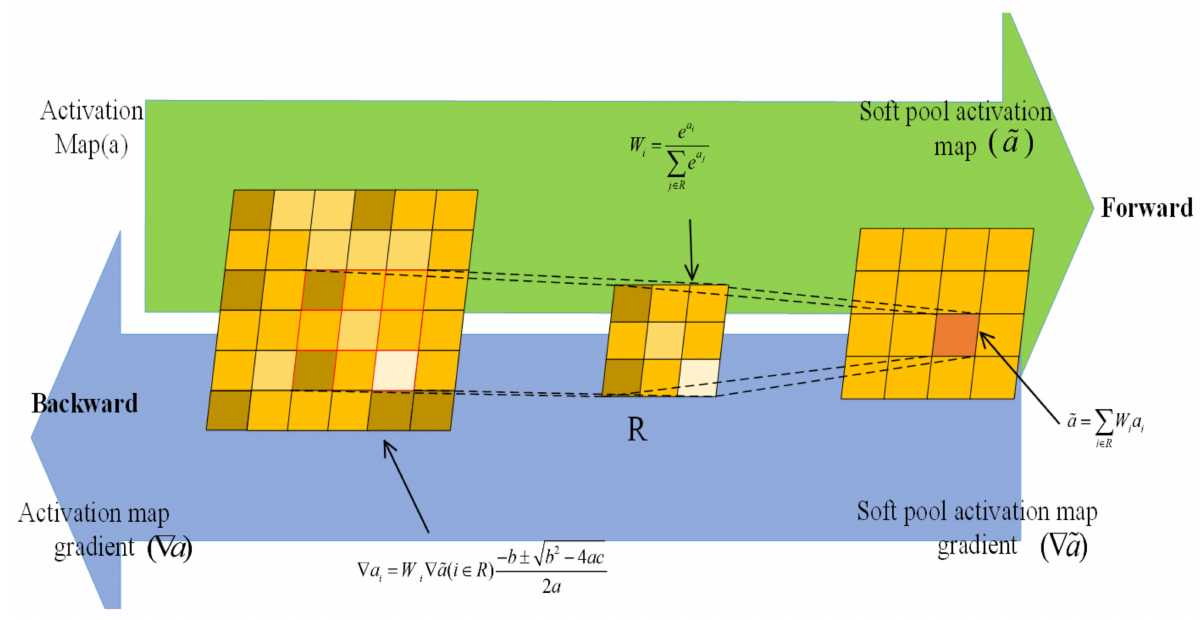
Figure 4. The schematic diagram of